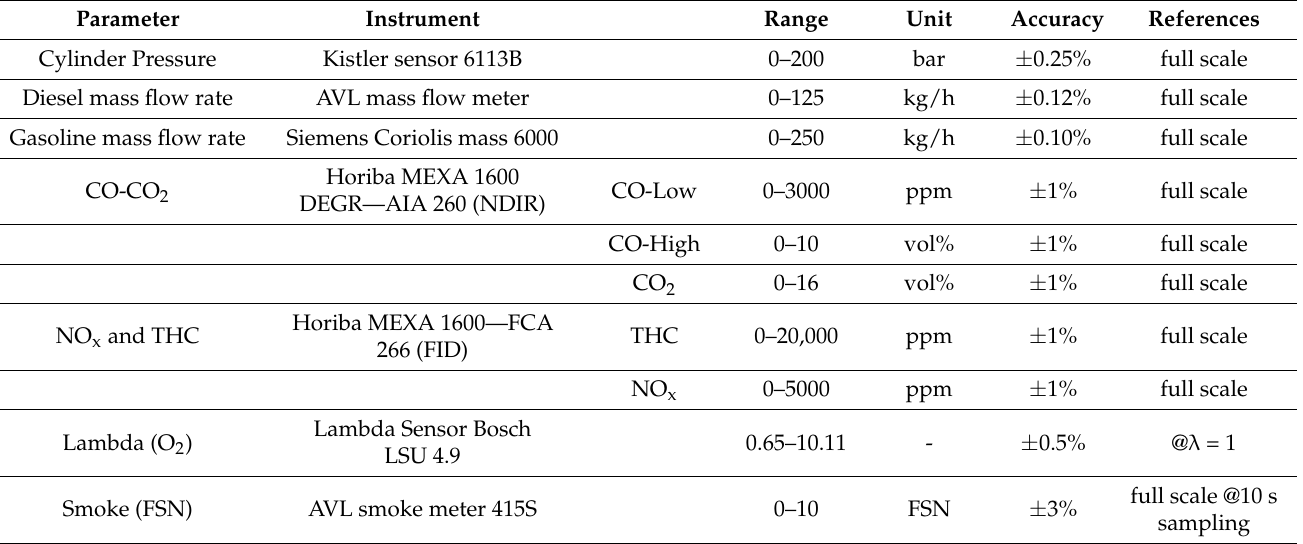
Table 2. Main characteristics of the most relevant sensors and analyzers used in the experimental